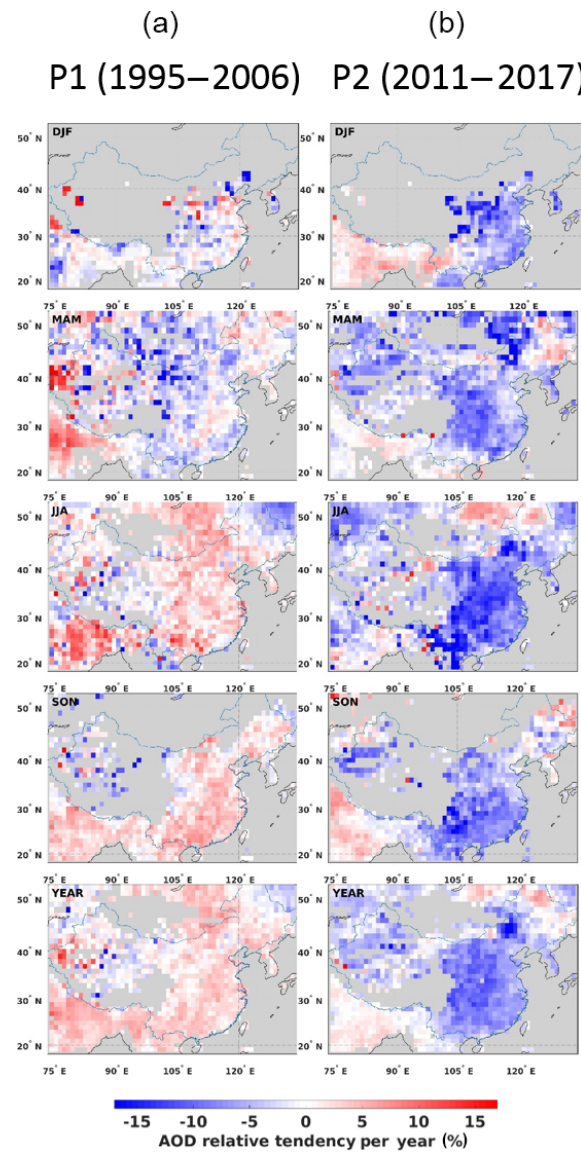
Figure 8. AOD relative tendencies (per year, see color bar) from seasonally and annually aggregated combined AOD time series for two periods: 1995–2006 (P1, a ) and 2011–2017 (P2, b